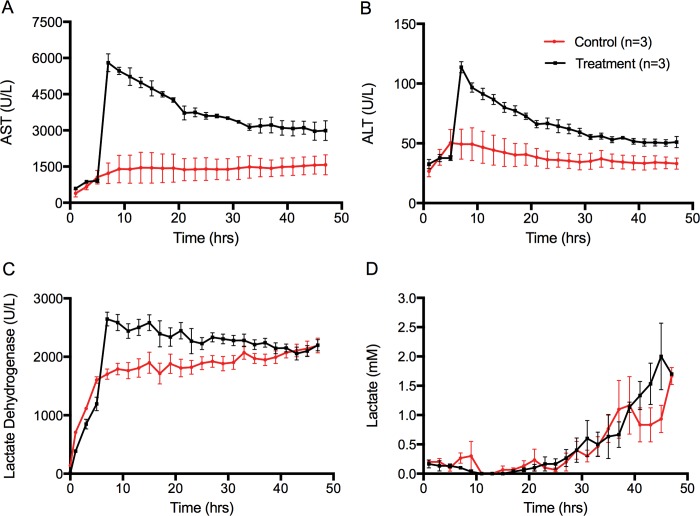
‘On circuit’ perfusate biochemistry during NMP.(A) Circulating AST perfusate levels during NMP, (p<0.0001). (B) Circulating ALT perfusate levels (p<0.0001). (C) Ex situ circulating perfusate lactate dehydrogenase levels at each hemoglobin level (p<0.0001). (D) Lactate levels at each time point (p = 0.24). Data points show means and SEM, 95% confidence interval. Aspartate aminotransferase (AST), Alanine aminotransferase (ALT).